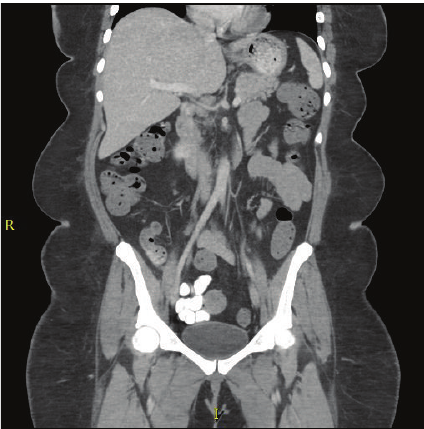
Figure 3: Showing resolution of Pneumatosis Intestinalis on CT